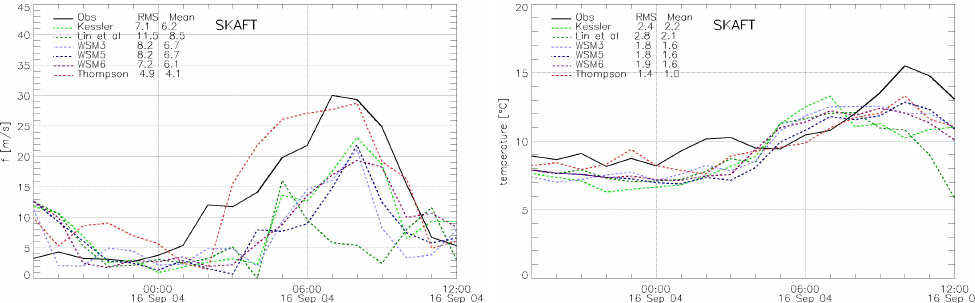
Fig. 8. Observed (solid black) and simulated (dashed) 10 m wind speed [ms − 1 ](left) and 2-m temperature [ ◦ ] (right) at station Skaftafell (WMO# 4172 – SKAFT) in the lee of Mt. Öræfajökull. Various colours represent various micro-physic parameterisations within the WRF model: Light green – Kessler, dark green – Lin et al., light blue – WSM3, dark blue – WSM5, purple – WSM6 and red – Thompson scheme.